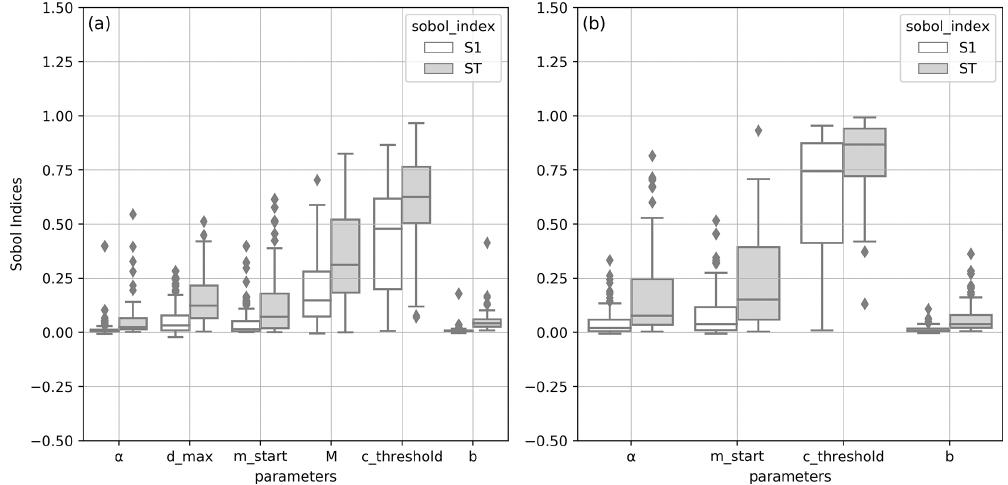
Figure 9. Distribution of first ( S 1)- and total (ST)-order Sobol indices in the modeled reservoirs for each parameter: (a) in irrigation and (b) in non-irrigation